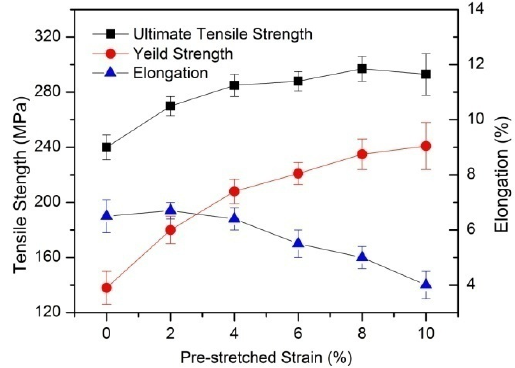
Figure 7. Mechanical properties of specimens subjected to pre ‐ stretch and subsequently aged at 200 °C for 8 h.